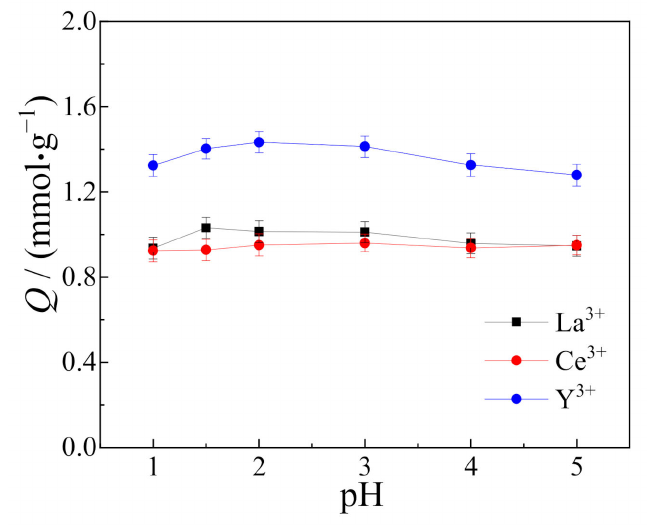
Figure 5. Solution pH effect on the adsorption capacity of